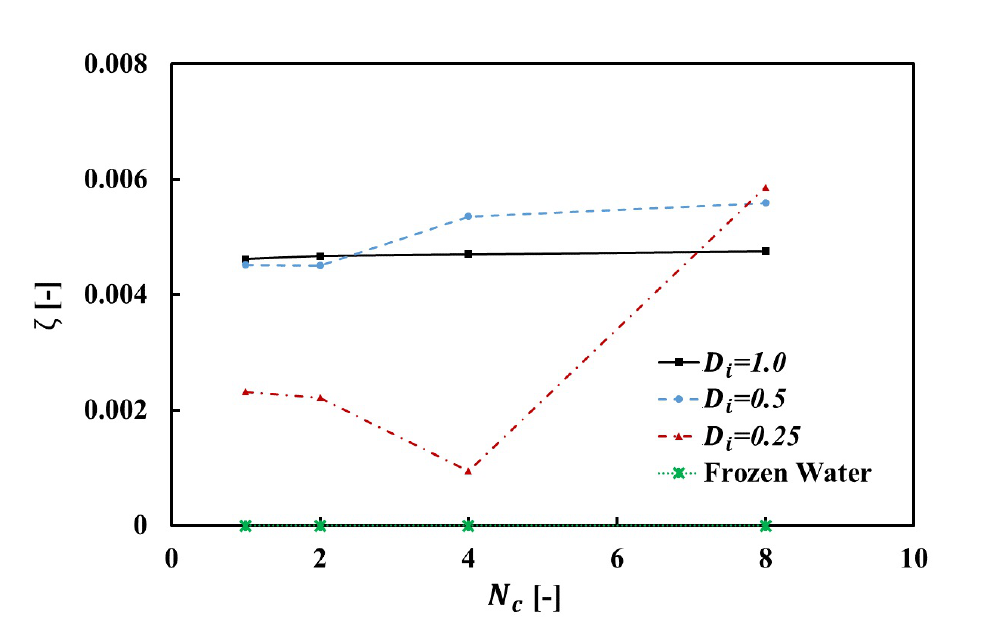
Figure 4. Damping ratio of the free decay beam–tank system with both sloshing water and frozen water as a function of the number of